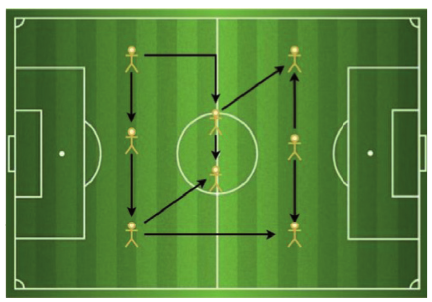
Figure 1: Example of the passing